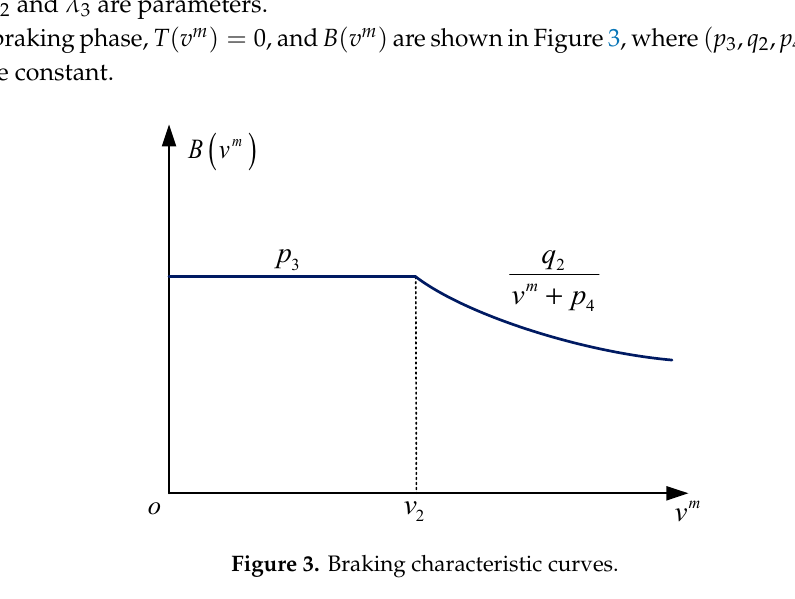
. Figure 2. Traction characteristic curves. In the cruising phase,